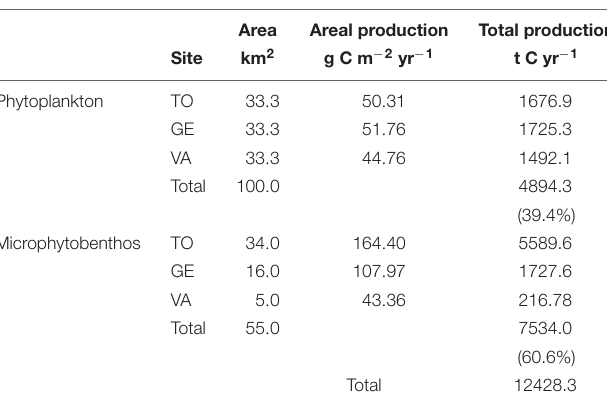
TABLE 2 | Summary of the data used for the upscaling of local areal primary production rates (g C m − 2 yr − 1 ) to ecosystem-level carbon fixation budget (t C yr − 1